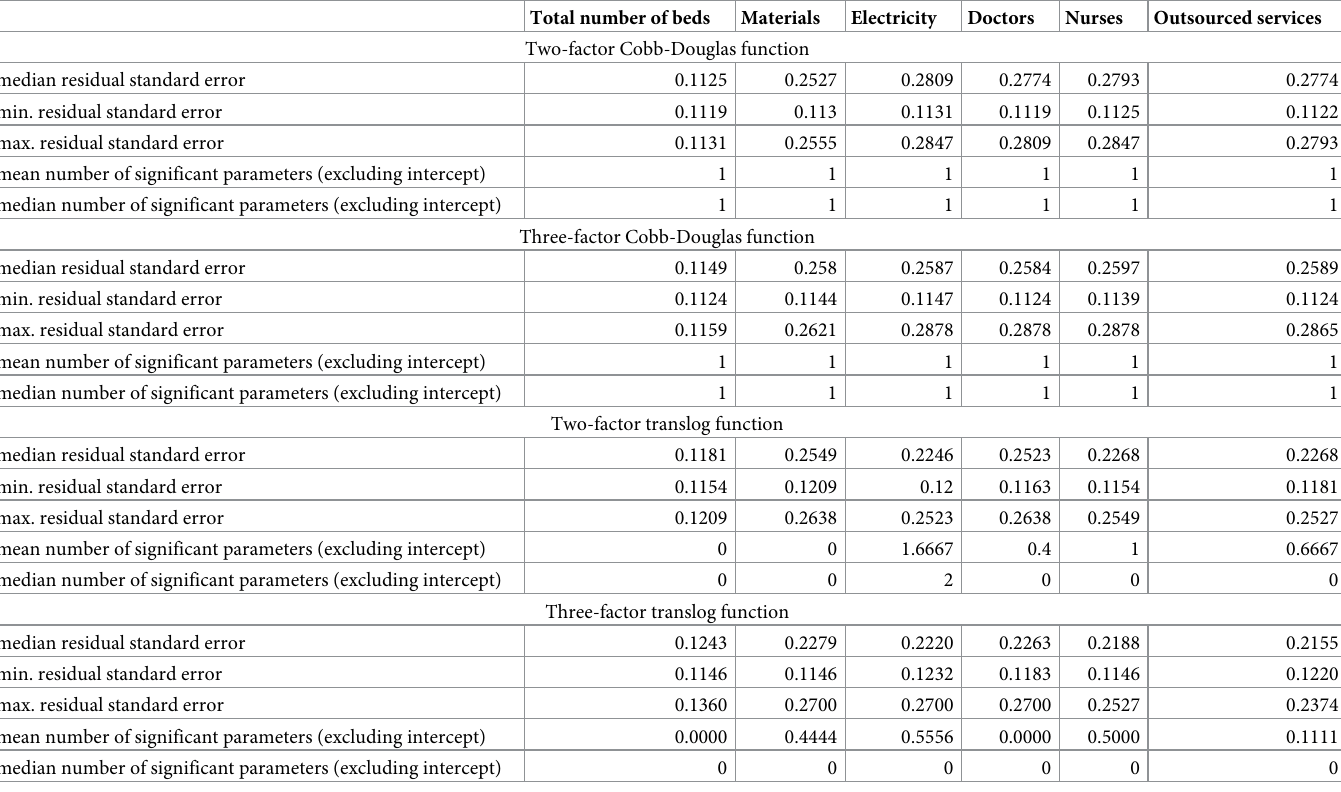
Table 6. Comparison of adjustment of two- and three-factor Cobb-Douglas and translog functions by explanatory variables (OLS,